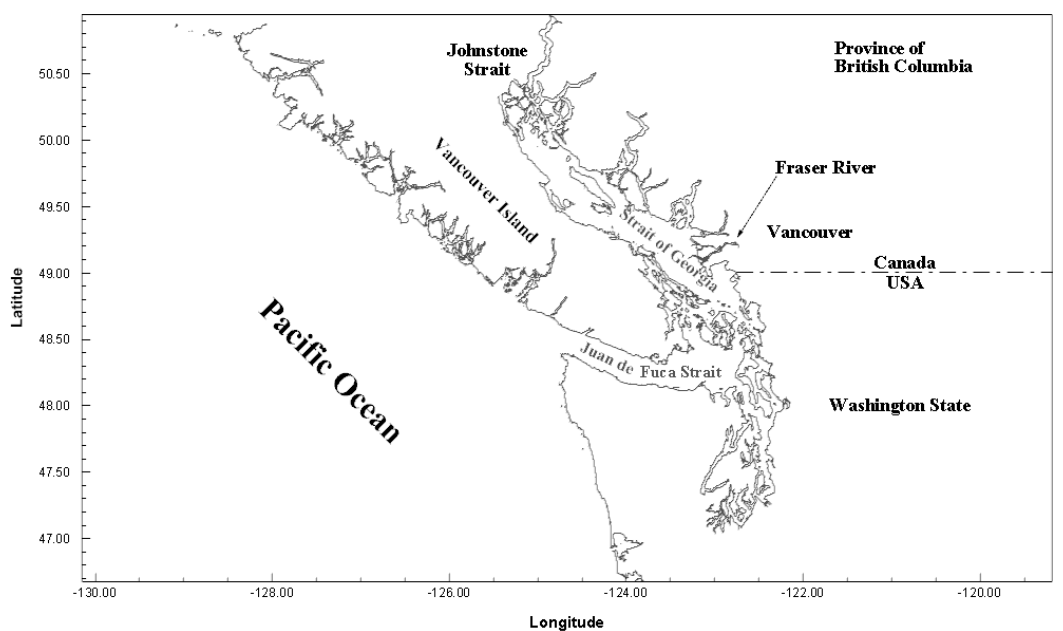
Figure 1. Study location of the Fraser River estuary.